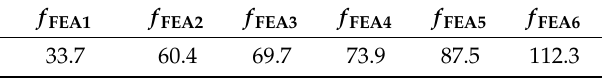
Table 2. Natural frequencies of the initial FE model. FEA—finite element analysis.